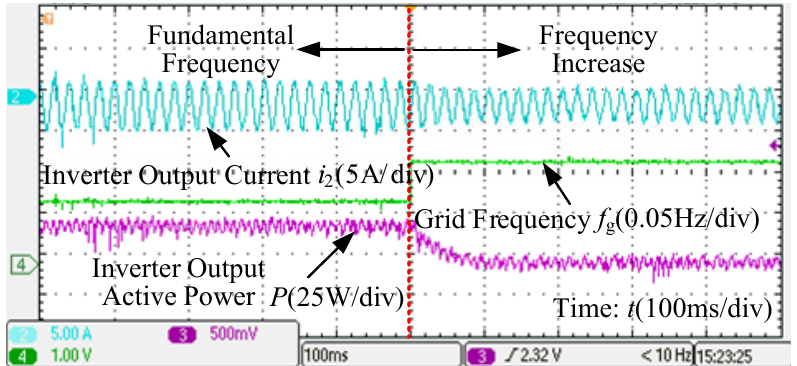
Figure 18. Inverter output current and output active power waveform when the grid frequency is reduced.